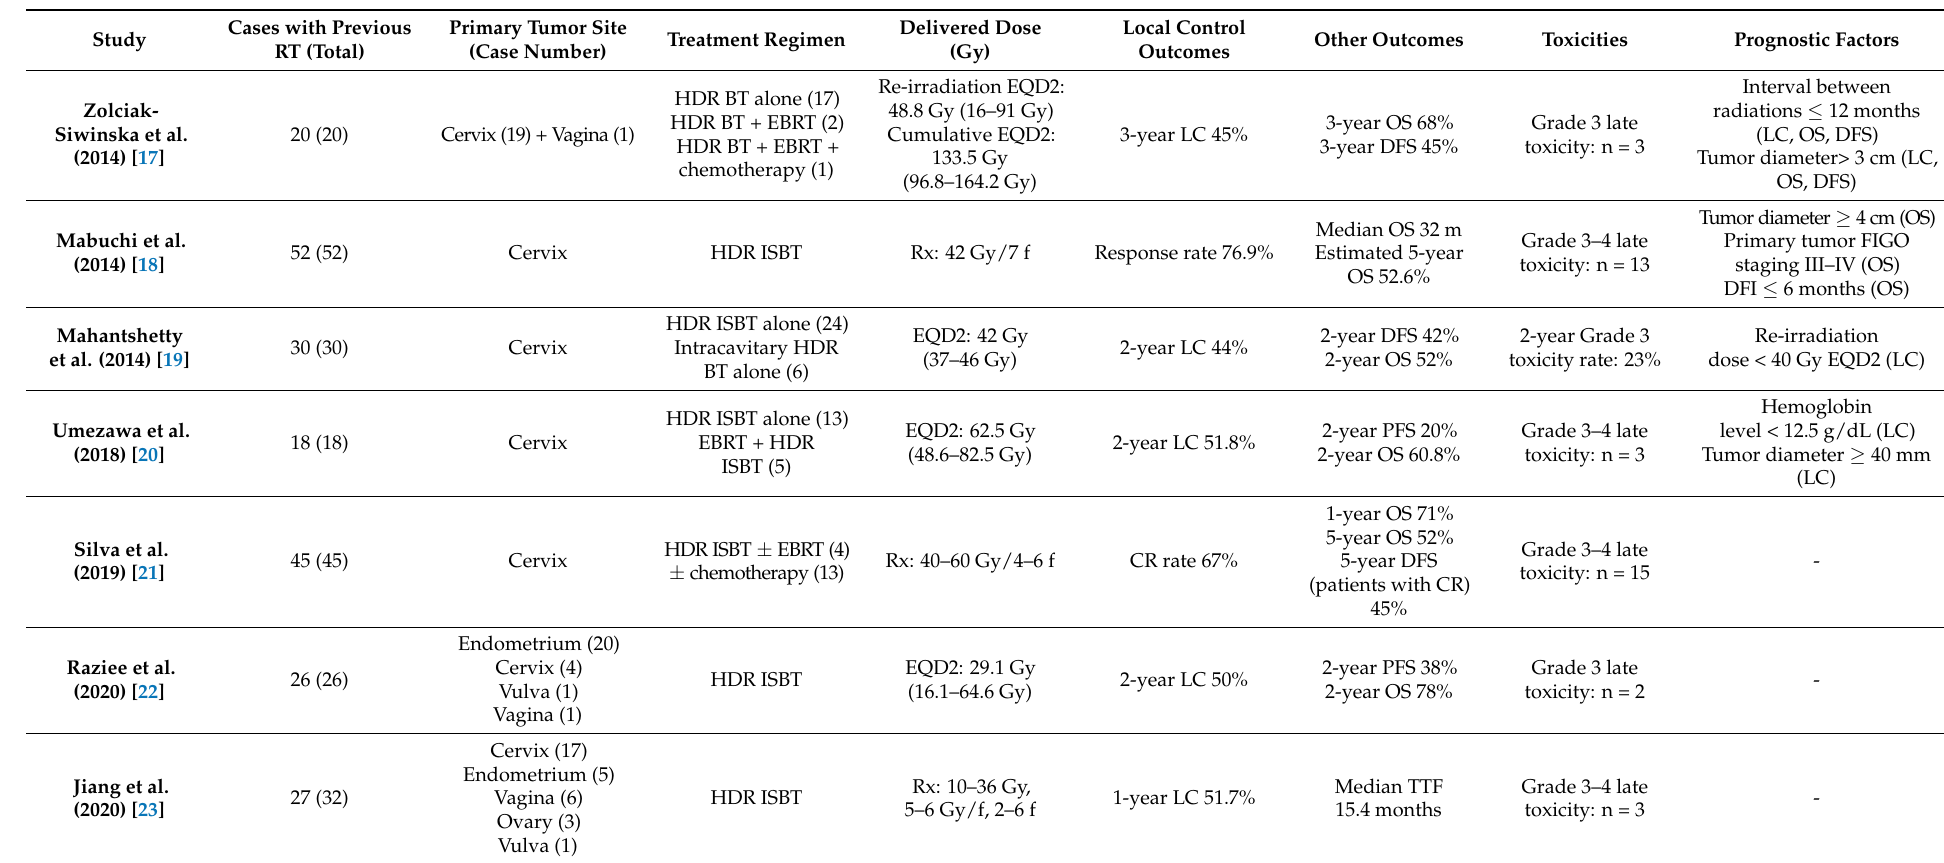
Table 1. Recent studies on re-irradiation with HDR-ISBT for recurrent cervical